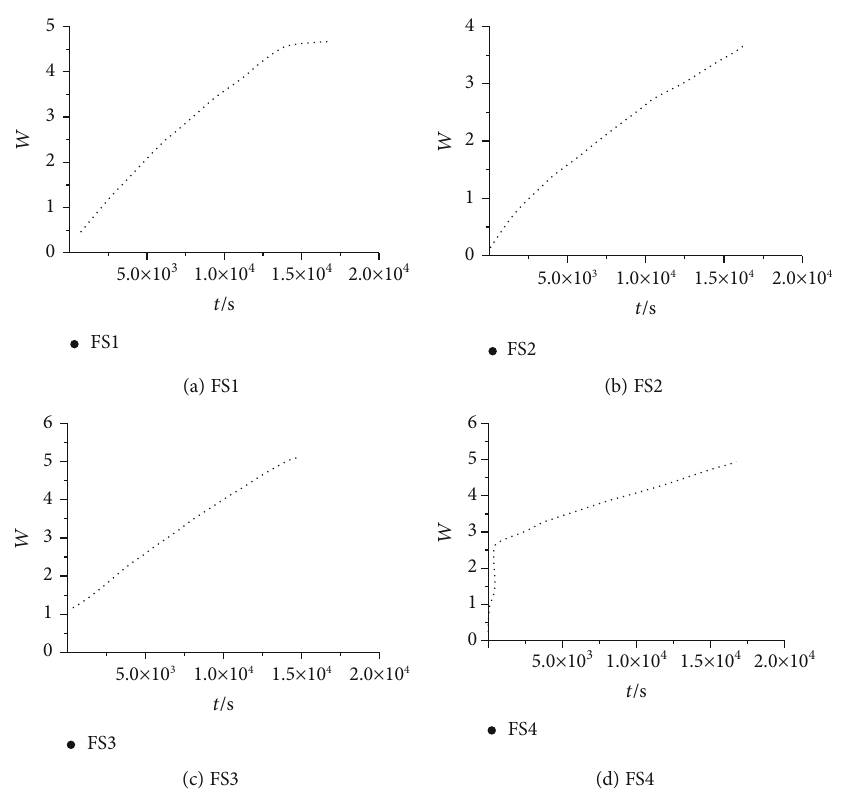
Figure 18: Pressure water absorption Q – t curve of the siltstone